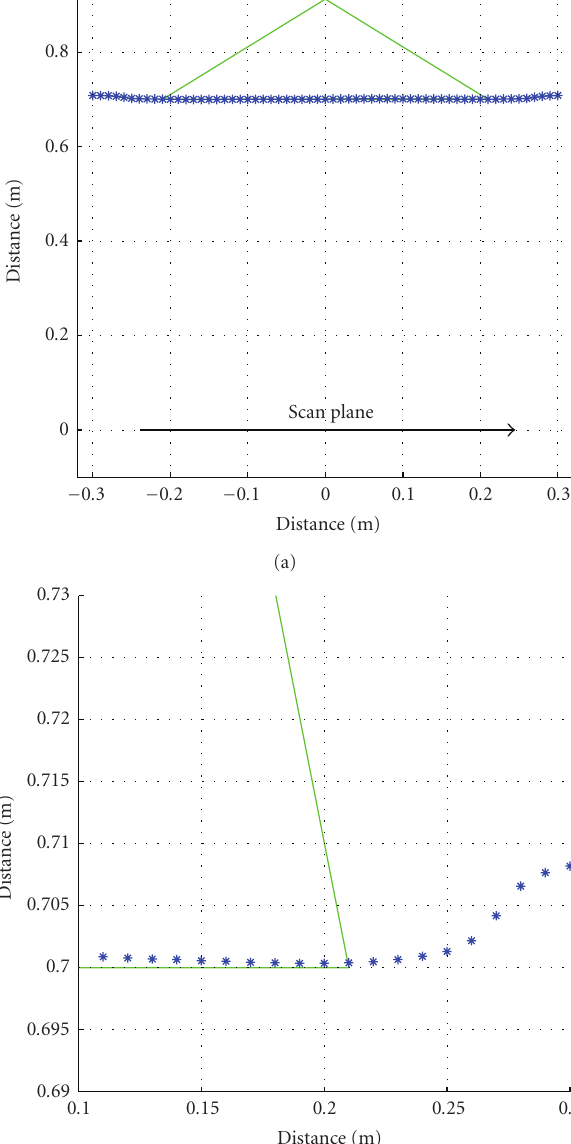
Figure 5: Measured radargram of a rectangle object (30cm by